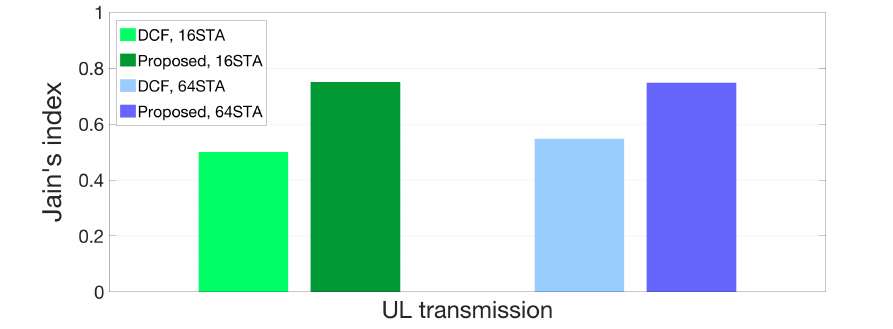
Figure 12. Fairness comparison between DCF and proposed protocol in UL